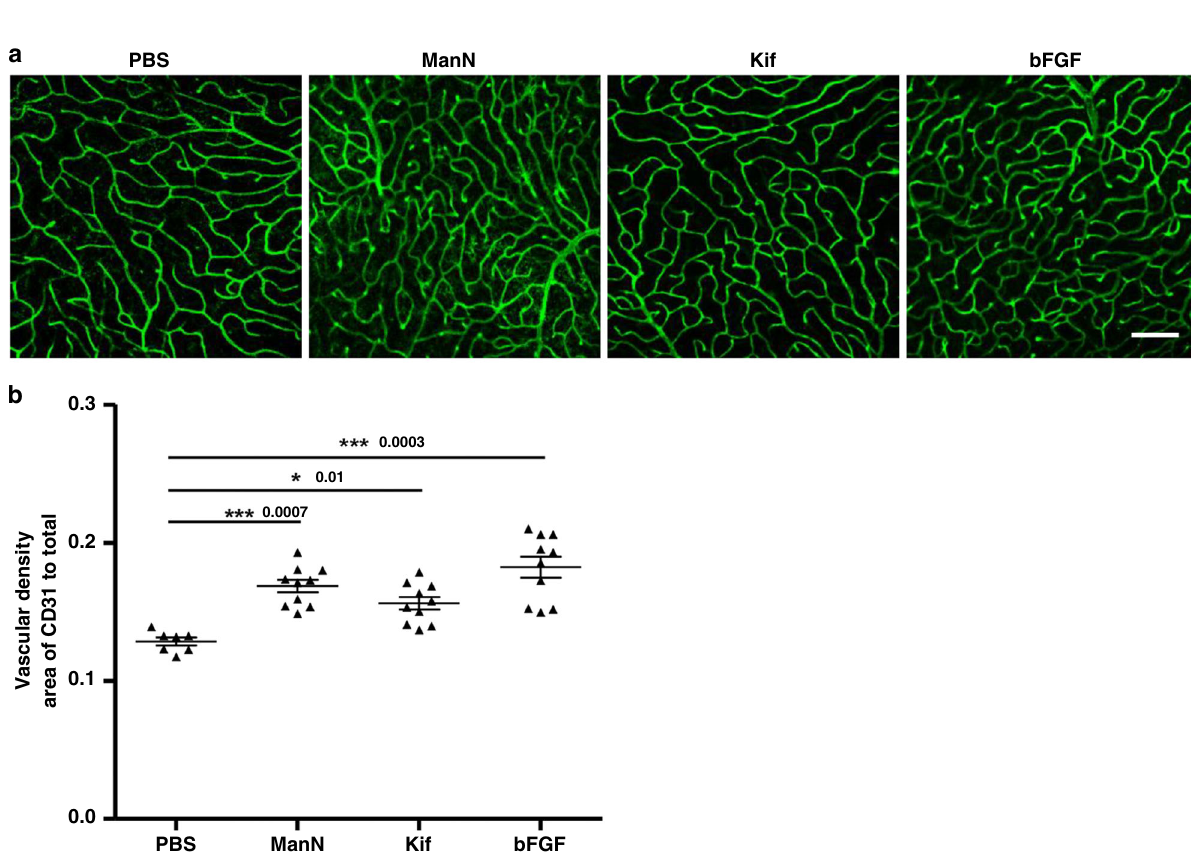
Fig. 10 ManN promotes retinal neovascularization in mice. a Intravitreal injection of ManN increases blood vessel density. Adult mice were intravitreally injected once 500 ng of ManN, Kif or 200 ng of bFGF. PBS was used as vehicle control. Seven days after injection, PFA- fi xed retinas were subjected to CD31 immuno fl uorescence. Representative images of CD31-positive vessels are shown. n = 10 animals/treatment group, 3 independent experiments, scale bar = 50 µ m. b Vascular density was determined with ImageJ software, n = 10 animals/treatment group, 3 independent experiments. Data were means + / − SEM. Statistical analysis was done by two-tailed, two-sample unequal variance t test. * p < 0.05, ** p < 0.01, *** p < 0.001. Data are provided as a Source data fi reagents were added at the indicated fi nal concentrations. After 3 – 6 days, cells were incubated with AlamarBlue ® for 4 h. Fluorescence was measured at 530 nm exci- tation wavelength and 590 nm emission wavelength. The experiments were repe- ated at least three times. To create a hypoxic condition, cells were placed in a hypoxia incubator with a mixture of gas consisting of 1% O 2 , 5% CO 2 , and 94% N 2 . On each 96-well plate, untreated and VEGF-treated (10 ng/ml) wells were included to monitor plate-to-plate variations. Twenty-percent methanol or 0.05% DMSO served as negative controls. 0.05% DMSO served as negative controls when Cas was tested in these cells. Human RMVECs and human adult DMVECs were split into Gelatin-coated 96 wells (2000 cells per well) in low-glucose DMEM containing 10% FBS. 1200 cells/well was set up for proliferation assay in low-glucose media con- taining 0.5% FBS. Data were collected at day 4 or 5. HUVEC (p7-10) were grown on gelatin-coated plate until it reached 70 – 80% con fl uency. On the day of the assay, cells were dissociated with 0.05% trypsin, which was neutralized with 0.5% FBS-containing EBM. Cells were brie fl y spun and then re- suspended in 0.5% FBS-media. Cells were counted and plated in 96-well, 1000 cells/ well. Triplicate wells were used for each treatment. Data were collected at day 3, and then cells were fi xed in 4% paraformaldehyde for 15 min before adding crystal violet. Cell-covered areas were quanti fi ed after taking pictures by Image J software.